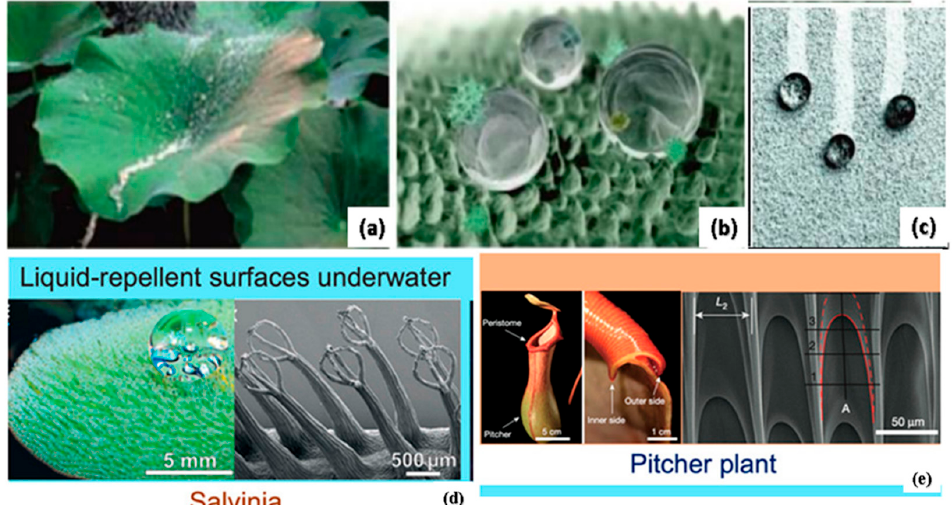
Figure 12. ( a ) Bioinspired pitcher plant surface paving the way for slippery surface, highlighting the micro- and macroscopic channels over the surfaces, ( b ) macroscopic channels allowing the flow of water into the pitcher plant, providing a slippery pathway, and ( c ) microscopic channels stabilizing water films and trapping insects [286]. Copyright permission from Elsevier, 2021. Table 4. The tribological behavior of various biomimetics surfaces by plants.